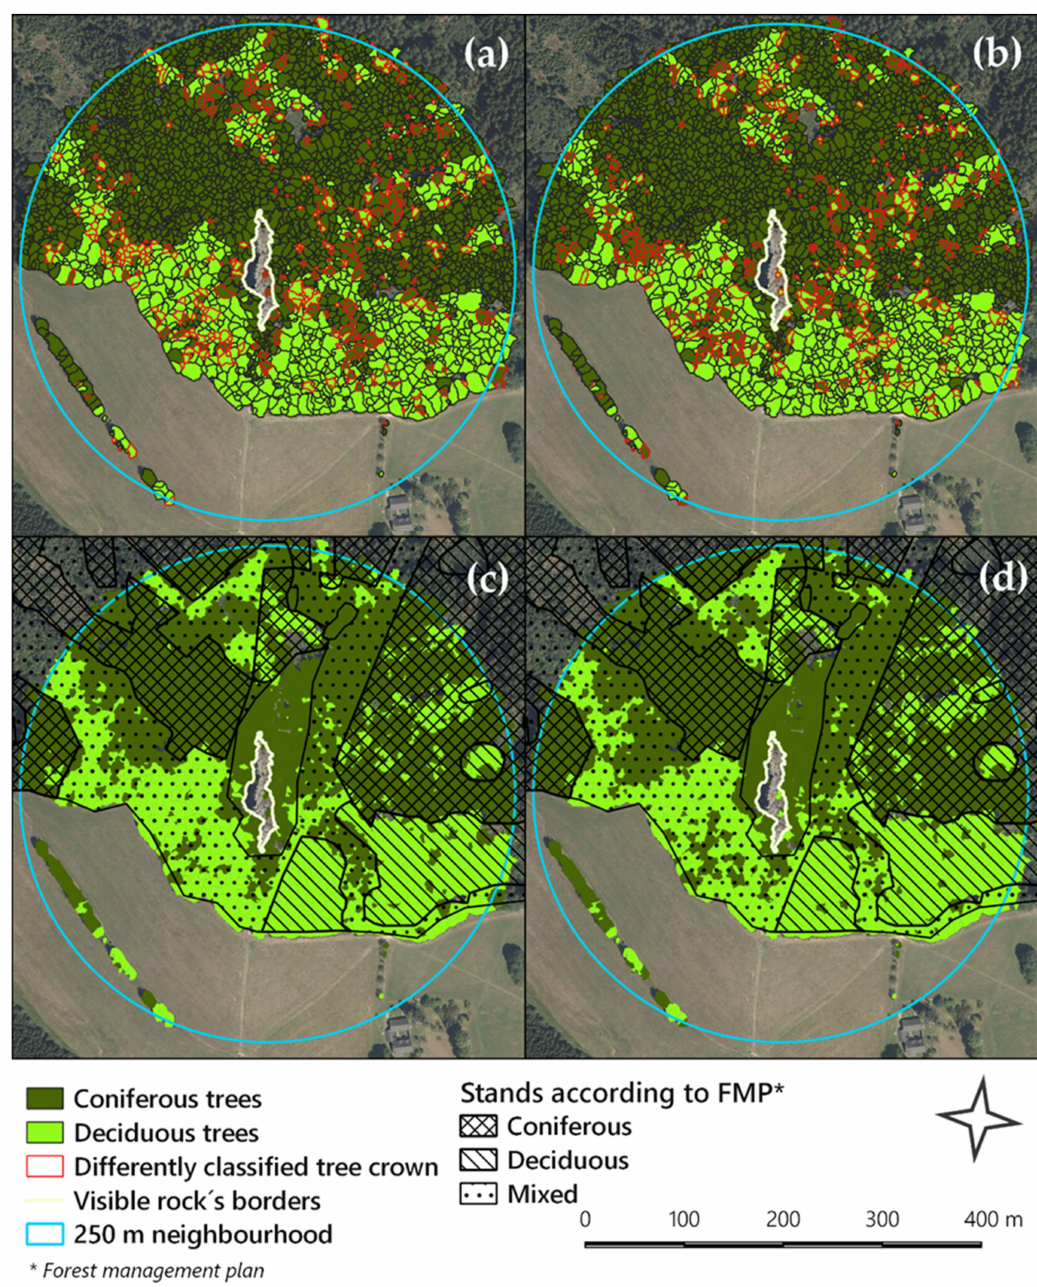
Figure 9. ( a ) The result of orthophoto tree classification, ( b ) the results of NDVI image classification and the di ff erences between them (red polygons), ( c ) comparison of the orthophoto classification with a simplified forest stand map, and ( d ) and comparison of the NDVI classification with a simplified forest stand